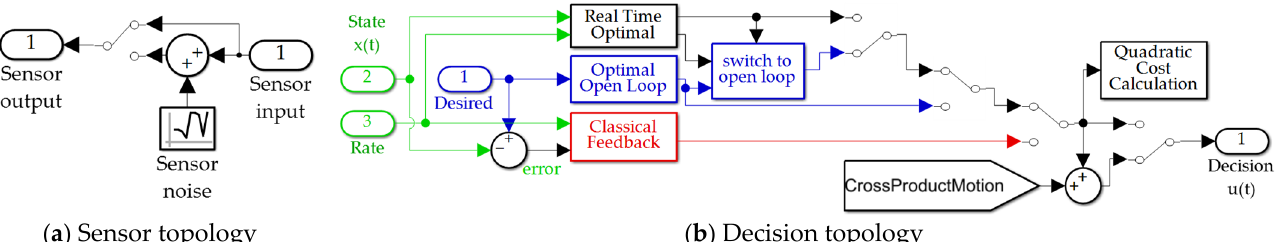
Figure 3. Simulink systems for noisy sensors and decision criteria (guidance or control) subsystem: ( a ) noisy sensor subsystem; ( b ) decision topology (guidance or control).